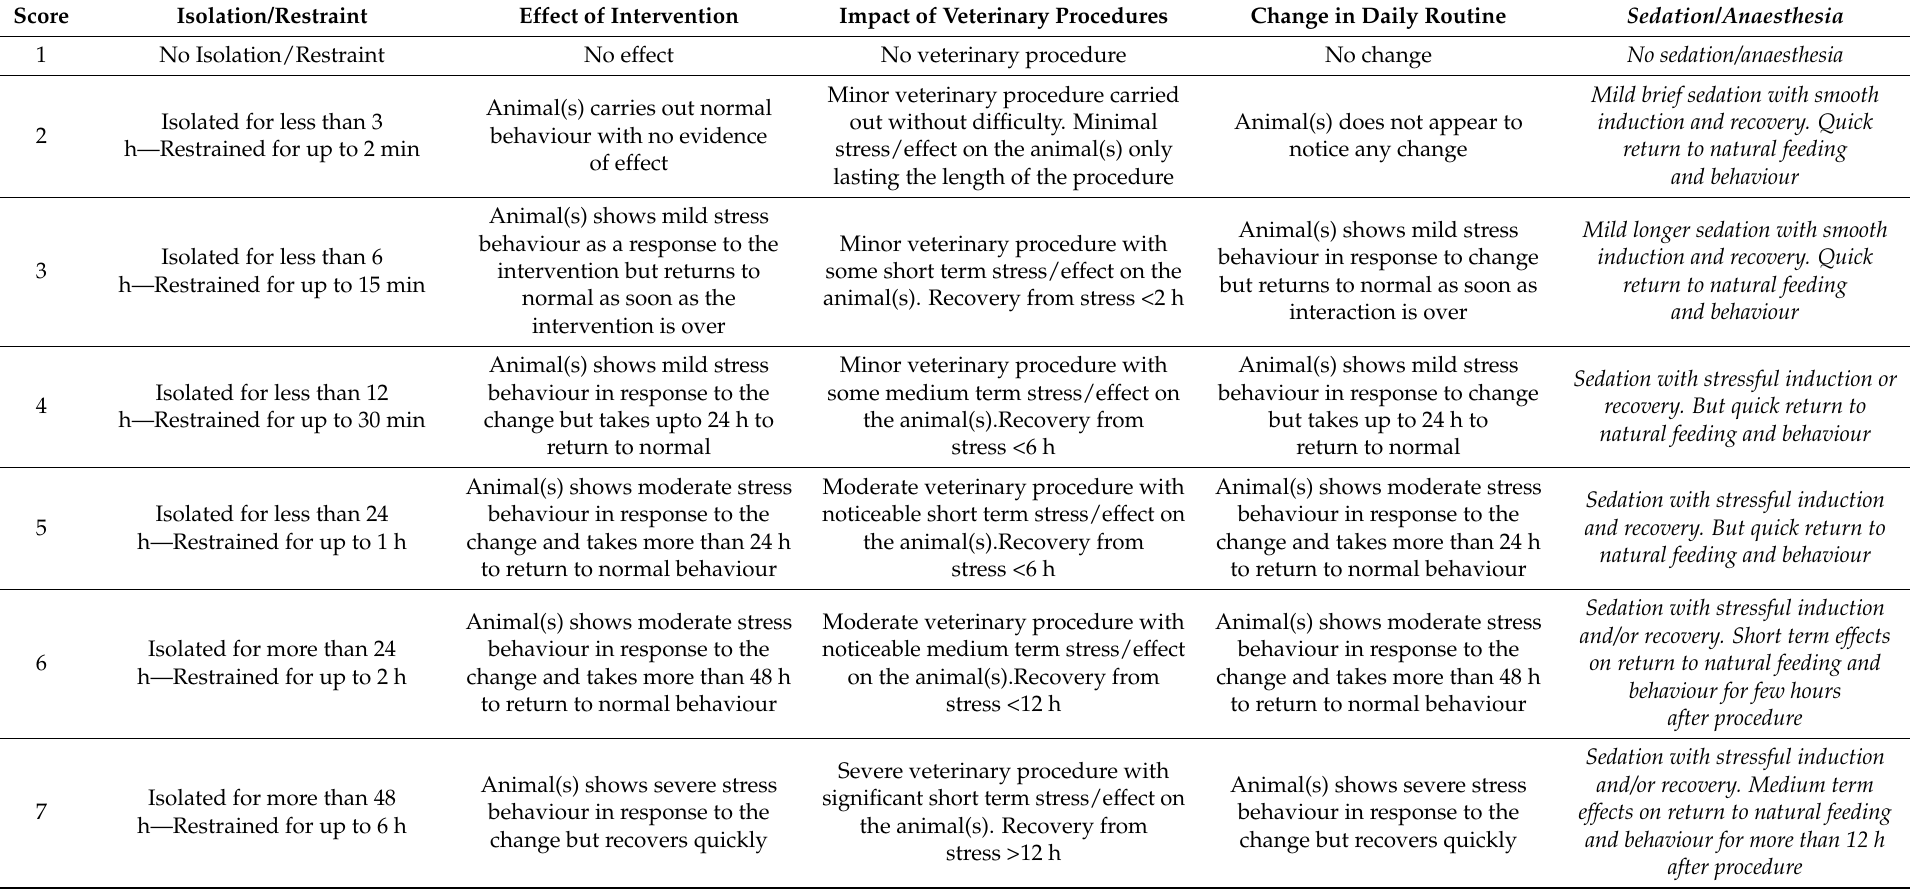
Table 4. Procedural parameter scoring for the AWAG assessment (Italics—factors assessed in cephalopods